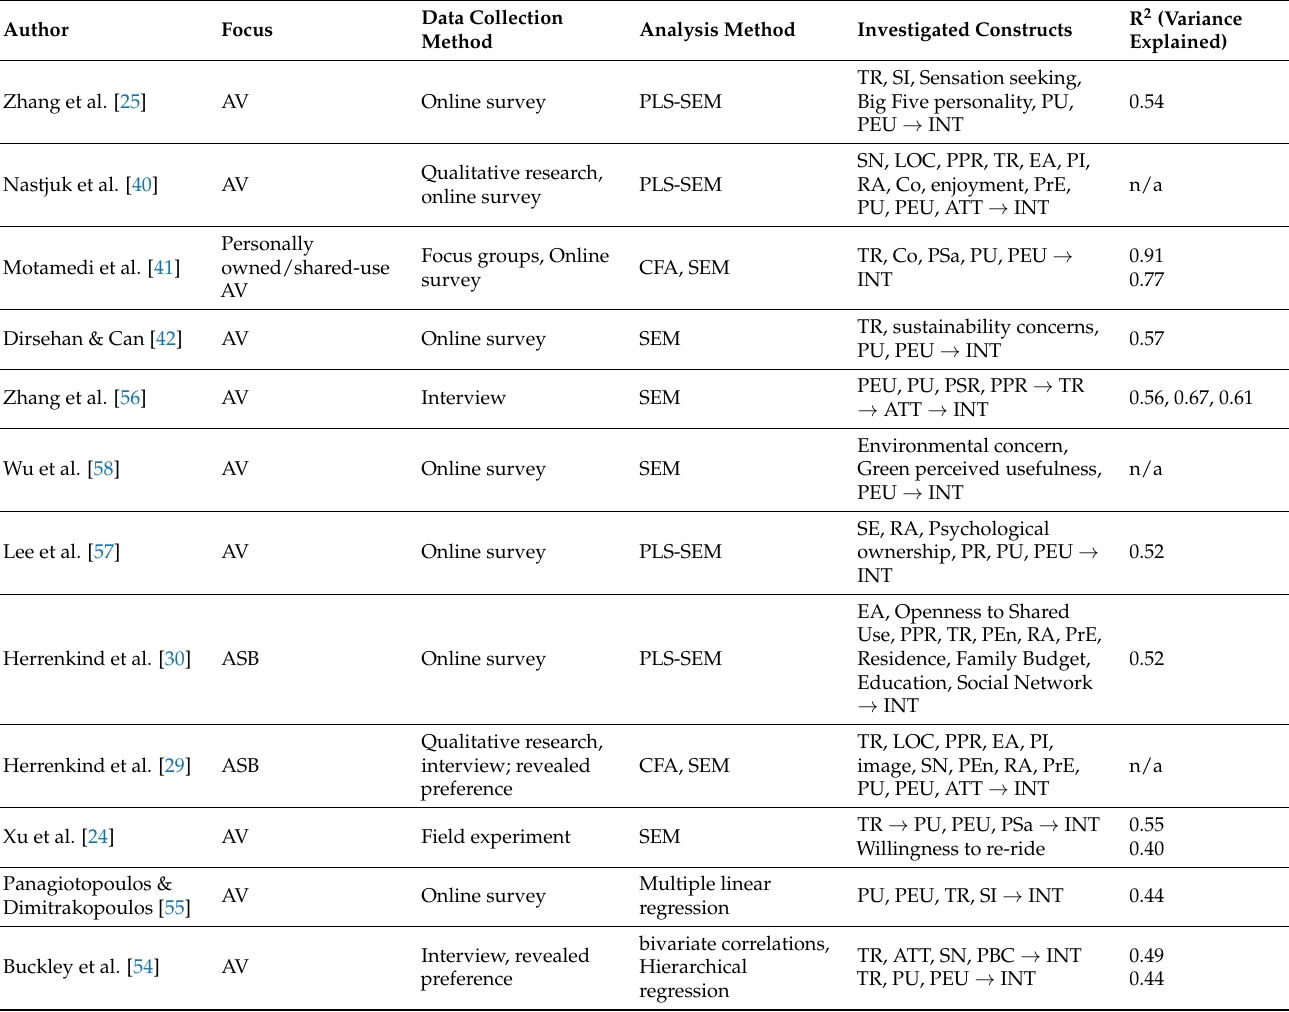
Table 1. Prior studies on AV adoption based on TAM and its